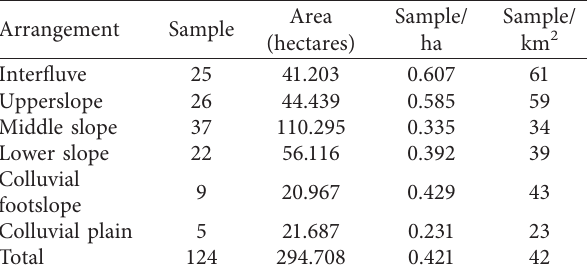
Table 4: Sampling density for the geomorphometry method per landform arrangements.